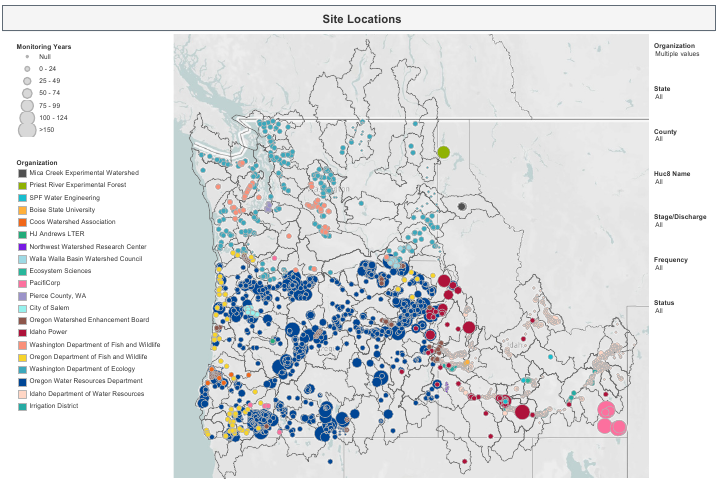
Figure 2. The Streamflow Data Catalog online visualization (https://tableau.usgs.gov/views/ Streamflow_Catalog/Introduction (accessed on 3 Faburary 2023)) shows all of the sites in the catalog and provides users the ability to select and filter the sites based on available metadata. Circles represent each monitoring location in the dataset and are scaled to the length of the data record. Note that incomplete metadata, such as missing start and end dates results in displaying the number of monitoring years as zero. While 32 individual organization’s datasets are in the catalog, some orga- nizations are grouped to improve the visualization (e.g., irrigation districts and Oregon Watershed Enhancement Board grantees). The U.S. Forest Service and Idaho Department of Environmental Quality discrete measurements are not shown in this figure as the number of locations precludes the ability to see other